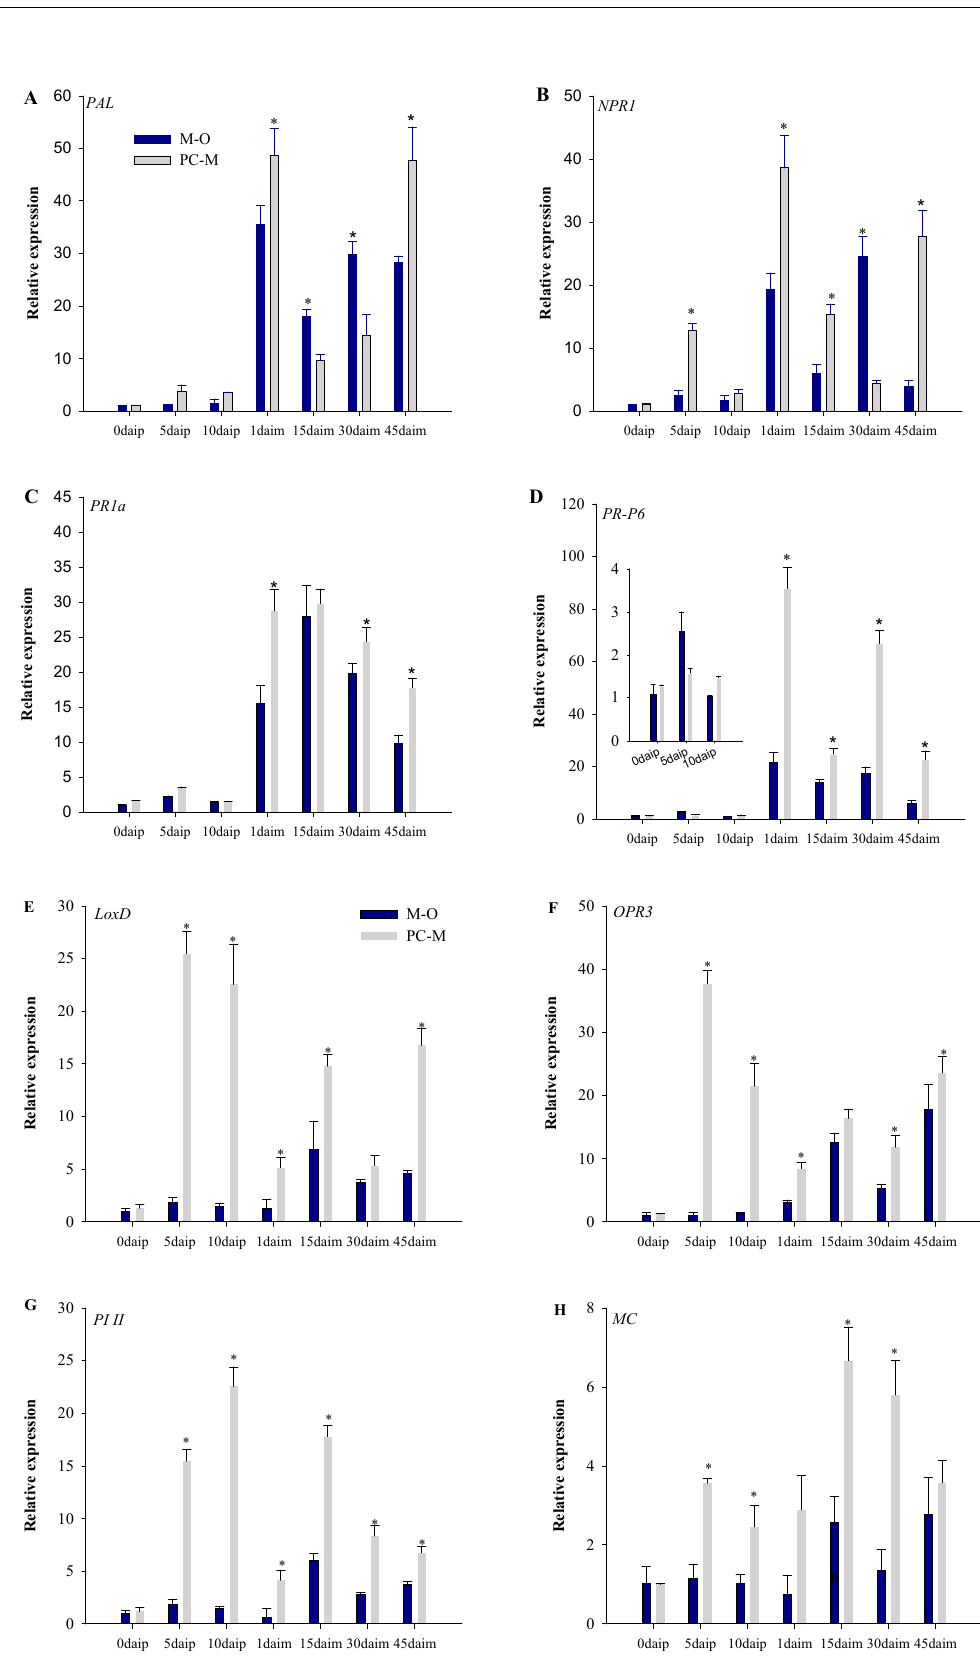
Figure 6. The expression changes of the salicylic acid (SA) marker genes and the jasmonic acid (JA) marker genes. M–O: Just the left root system was challenged with Meloidogyne incognita . PC–M: The left root system was pre-inoculated with PC-170, while the right was challenged with M. incognita . daip: days after inoculation with PC-170; daim: days after inoculation with Meloidogyne incognita .